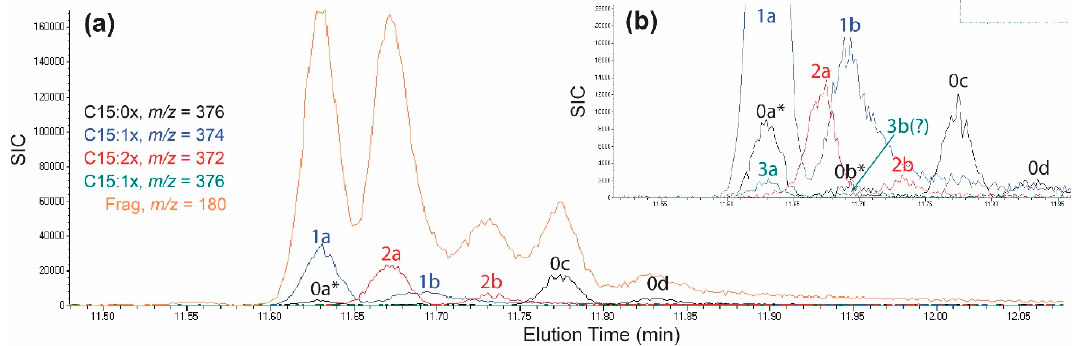
Figure 5. Selective ion chromatograms for C15-cardanol congeners and isomers. ( a , b ) Two C15-cardanol chromatograms illustrating different congener and isomers.